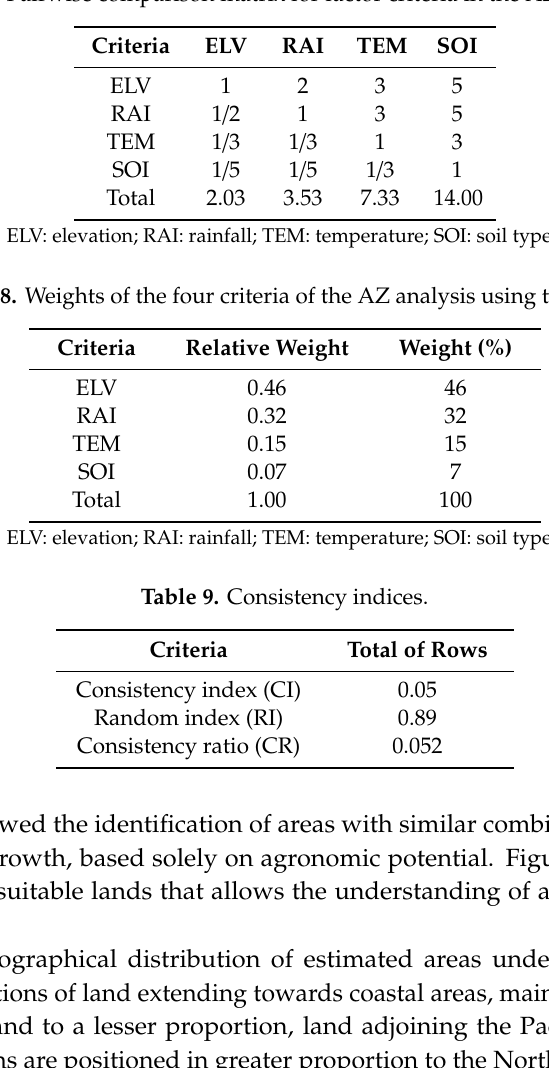
Table 7. Pairwise comparison matrix for factor criteria in the AZ analysis.